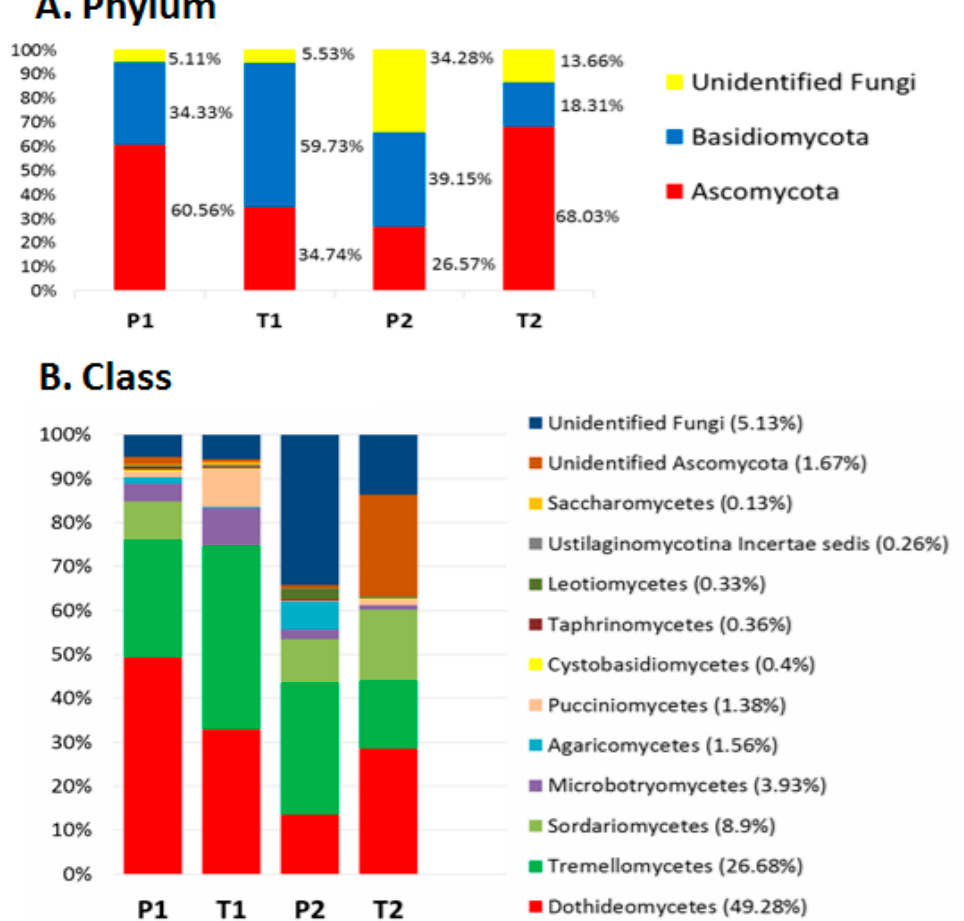
Figure 3. Structure and richness of the wheat endophytic fungal communities. Richness of fungal phyla (A) and classes (B) resulting from downstream analyses of the HTS performed on DNA extracted from wheat sap. Average relative abundance for each class is reported in parentheses. Sample categories are: P1 = Perciasacchi from Field 1; T1 = Tumminia from Field 1; P2 = Perciasacchi from Field 2; and T2 = Tumminia from Field